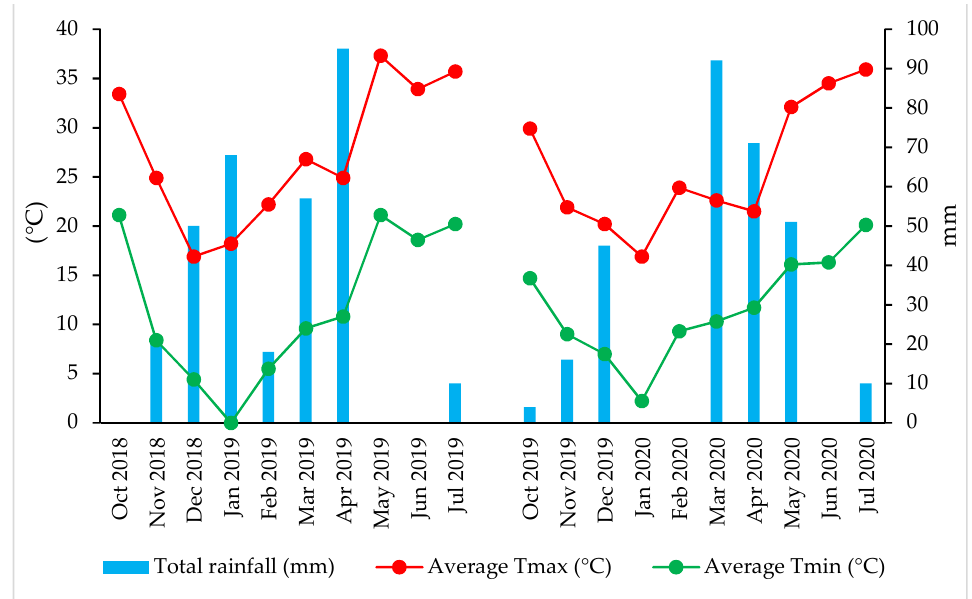
Figure 1. Variation of temperature and rainfall during the 2018–2019 and 2019–2020 seasons.